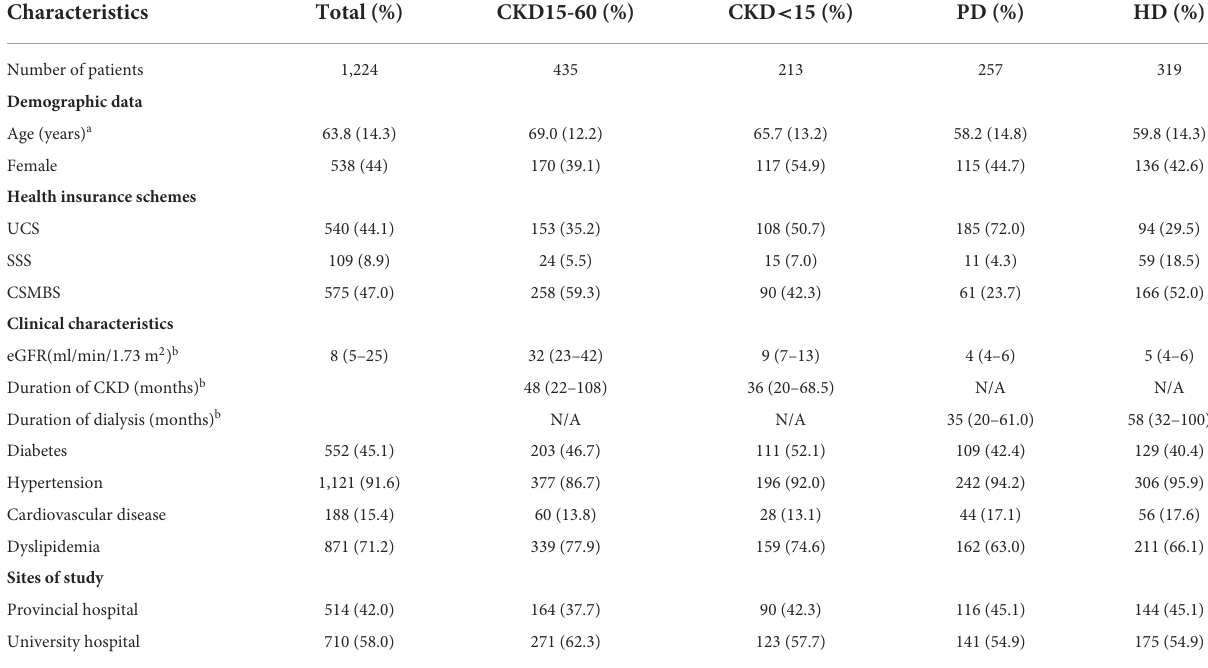
TABLE 1 Demographic and clinical characteristics by CKD groups.